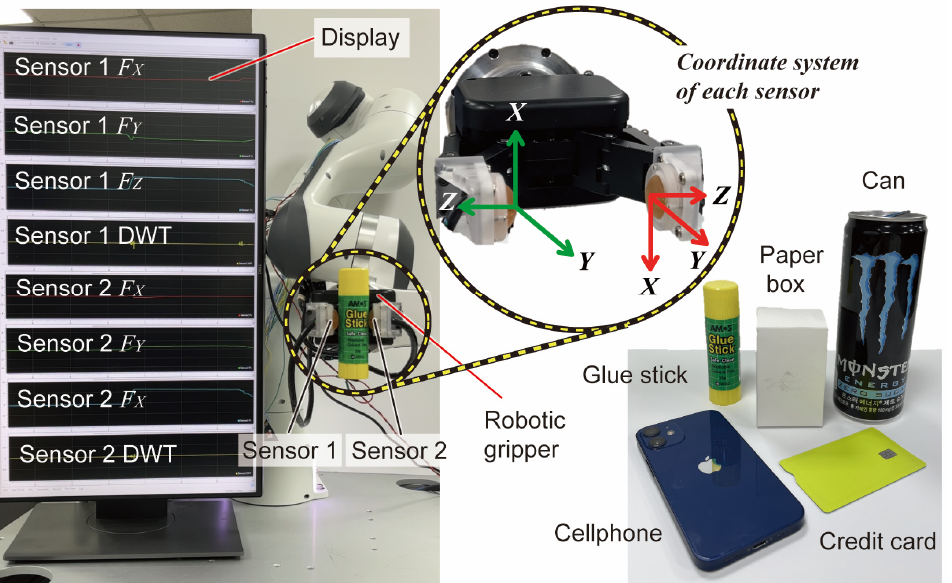
Figure 10. Experimental setup for practical applicability with common objects. Real-time plotting on the display of two sensors including three-axis forces and DWT result. Coordinate system of each sensor when installed on robotic gripper.